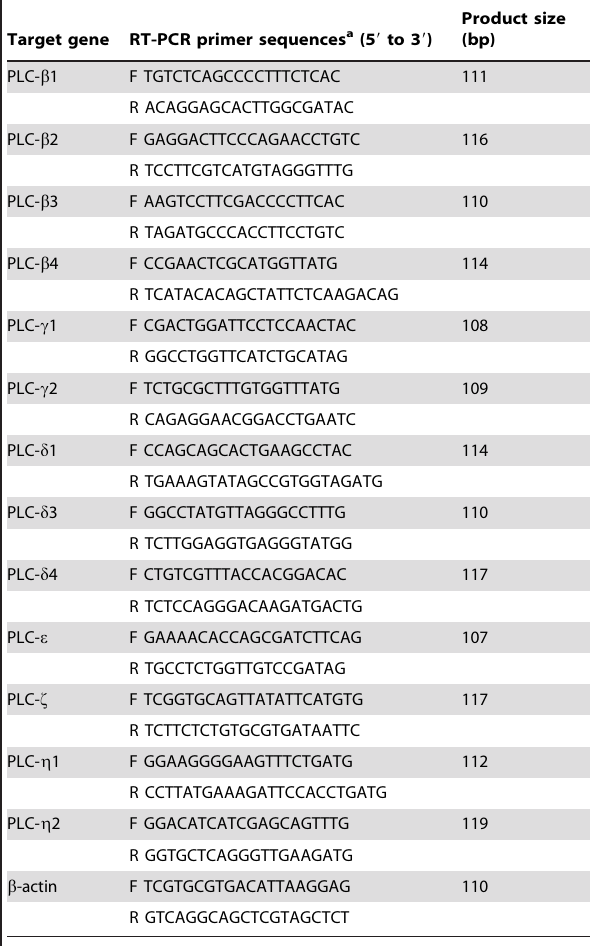
Table 1. Specific primer sequences for RT-PCR analyses.